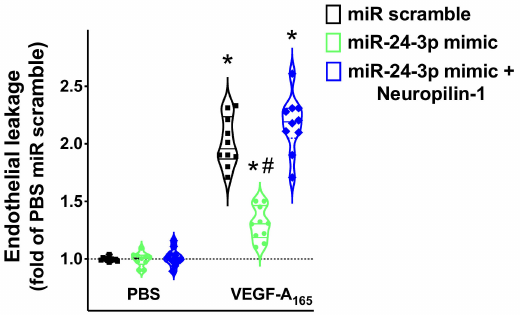
Figure 4. Targeting Neuropilin-1 by miR-24 significantly reduces endothelial permeability. En- dothelial leakage triggered by VEGF-A 165 (50 ng/mL) was measured in hBMECs transfected with miR-24-3p mimic, miR scramble, or combining miR-24-3p mimic and Neuropilin-1 overexpression;